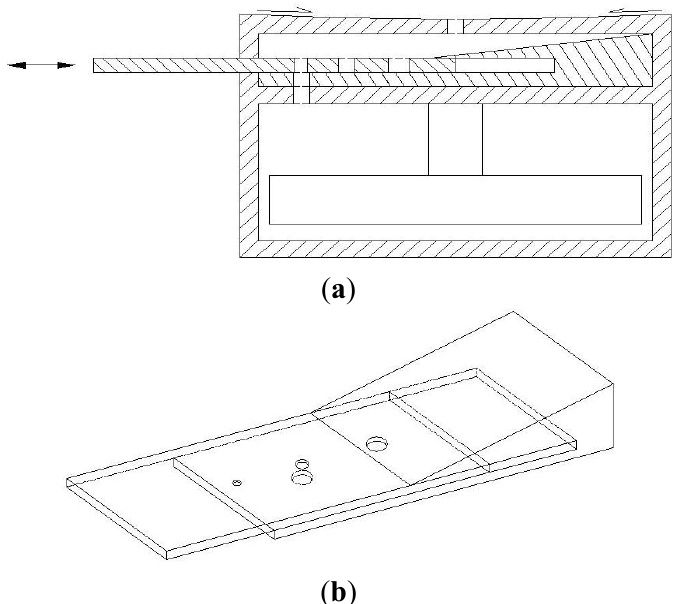
Figure 6. Liquid Compartment: ( a ) Section drawing of the liquid compartment, which indicates the space relationship between control device and upper/lower chambers; ( b ) Flow rate control